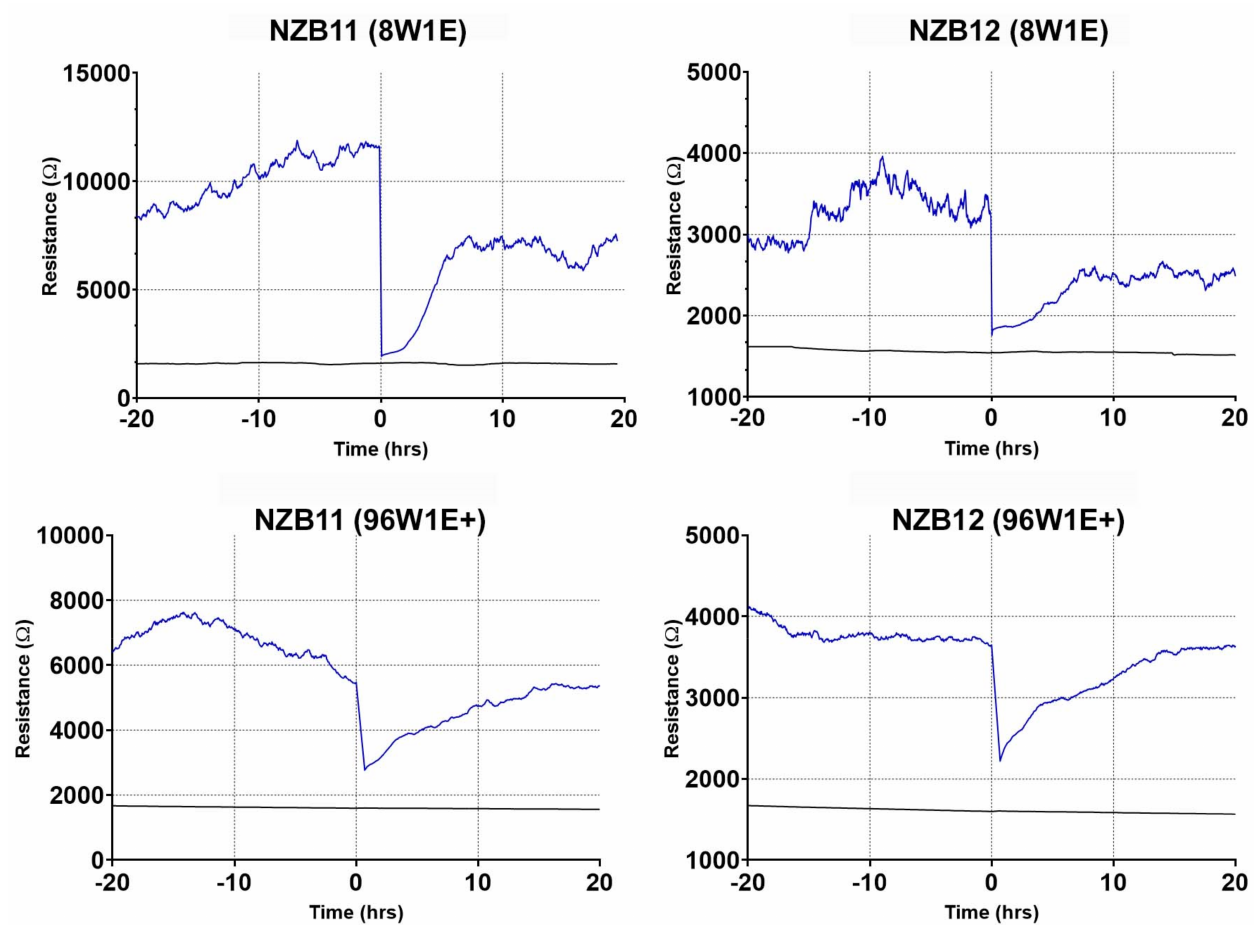
Figure 7. Comparative wound healing profiles of serum-derived GBM cells on 96W1E+ and 8W1E ECIS arrays. NZB11 and NZB12 serum-derived cells grown on 8W1E ECIS arrays for 76 h (time point at which stable resistance measurements are acquired). NZB11 and NZB12 serum-derived cells grown on 96W1E+ ECIS arrays for 95 h (time point at which stable resistance measurements are acquired). Cells were seeded at 80,000 cells per 0.33 cm 2 . Time 0 represent the point that the wounding current was applied. Resistance measurements were acquired at 4000 Hz. Data are representative of three independent